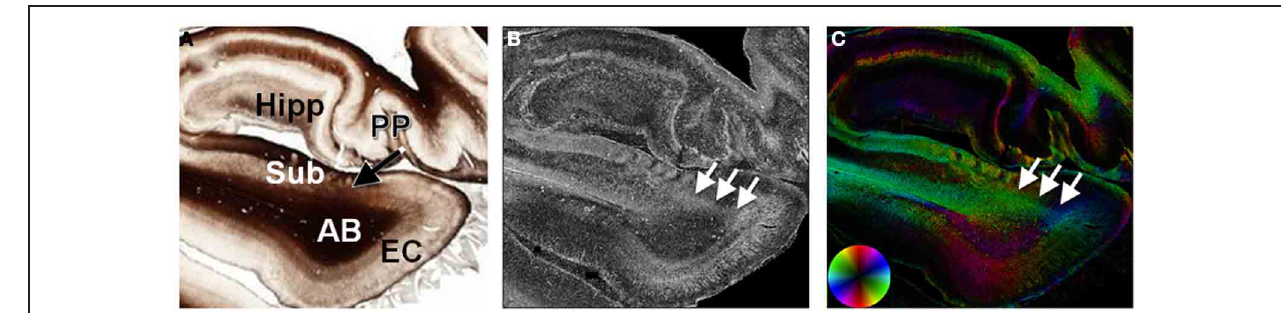
the angular bundle. In the maps of anisotropy (B) and orientation (C) , the perforant pathway is evident as a region of high anisotropy (arrows) projecting from the entorhinal cortex through the subiculum. AB, angular bundle; EC, entorhinal cortex; Hipp, hippocampal formation; PP, perforant pathway; Sub,